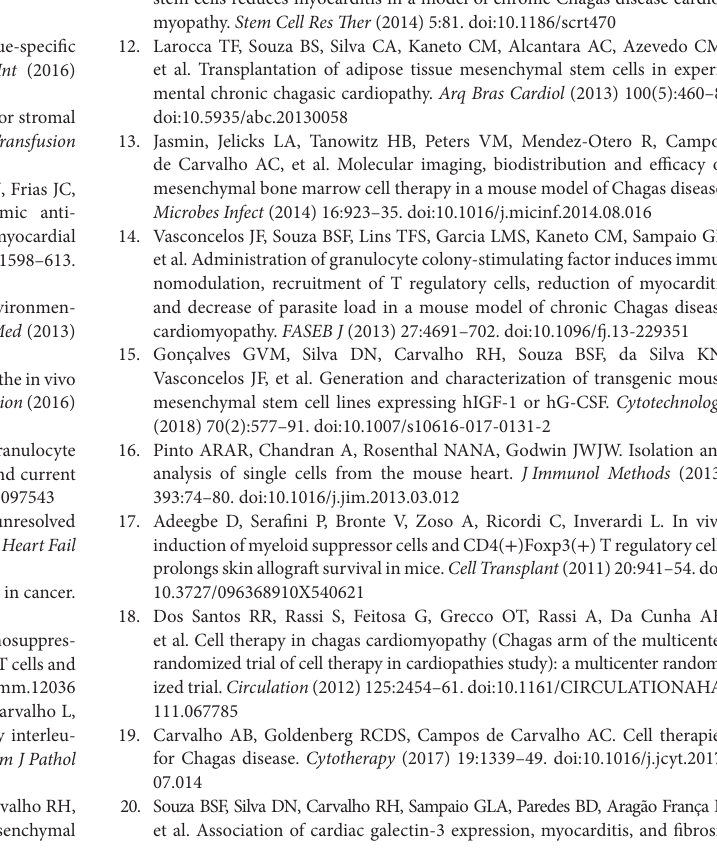
FigUre s1 | Experimental design. (a) Establishment of dose and administration regimen. C57BL/6 mice were treated with a single dose of 10 6 mesenchymal stem cells (MSCs) or MSC_G-CSF (i.p) and serial hemograms were performed during 7 days. (B) Cell tracking was performed in C57BL/6 mice chronically infected with T. cruzi (6 months after infection) 3 and 7 days after administration of 10 6 MSCs or MSC_G-CSF (i.p), for detection of GFP + cells and human granulocyte-colony stimulating factor gene in the heart. (c) C57BL/6 infected with T. cruzi was treated 6 months after infection with 10 6 MSCs or MSC-GCSF, every 7 days, during 60 days. Saline-treated and naïve mice were used as controls. Mice were euthanized for 30 days after the first administration of cells for evaluation of recruitment of myeloid-derived suppressor cells and regulatory T cells to the